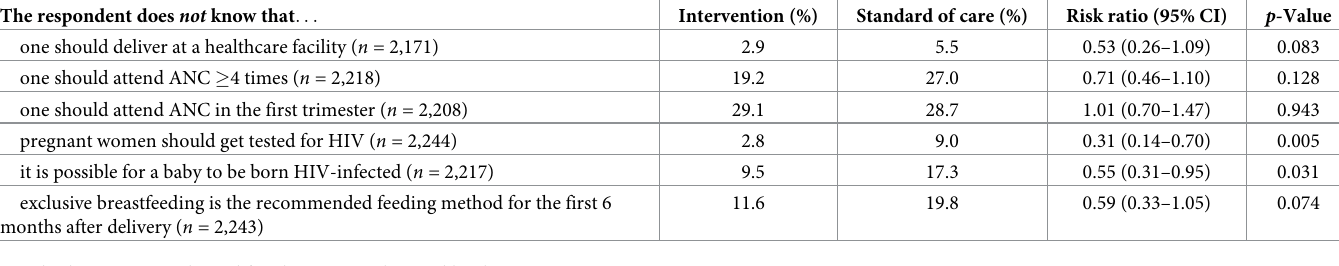
Table 3. Maternal health knowledge by study